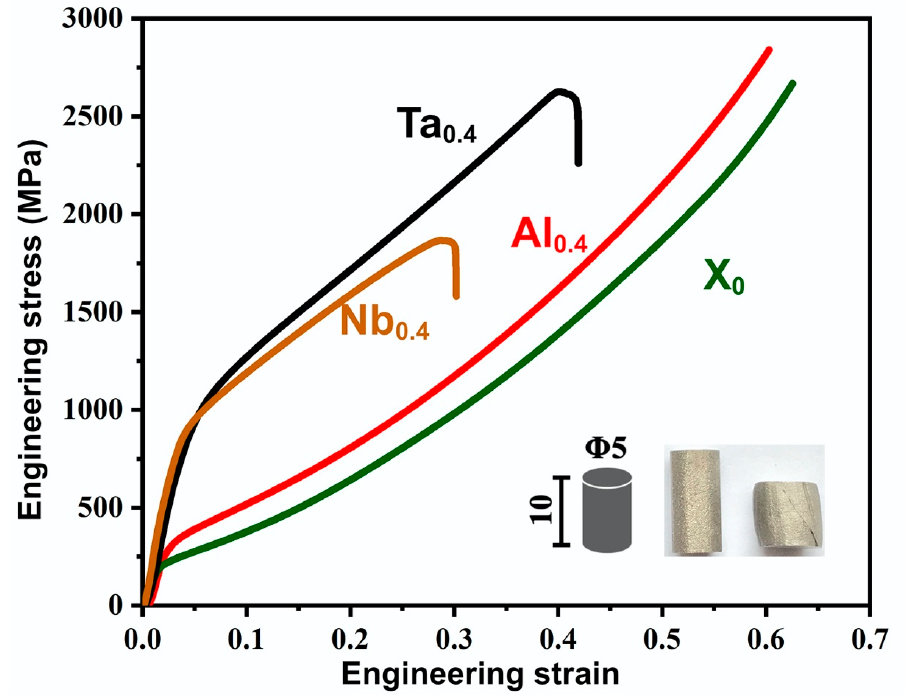
Figure 3. Compressive test result of the CoCrFeNiX 0.4 HEA prepared by PPA-AM.